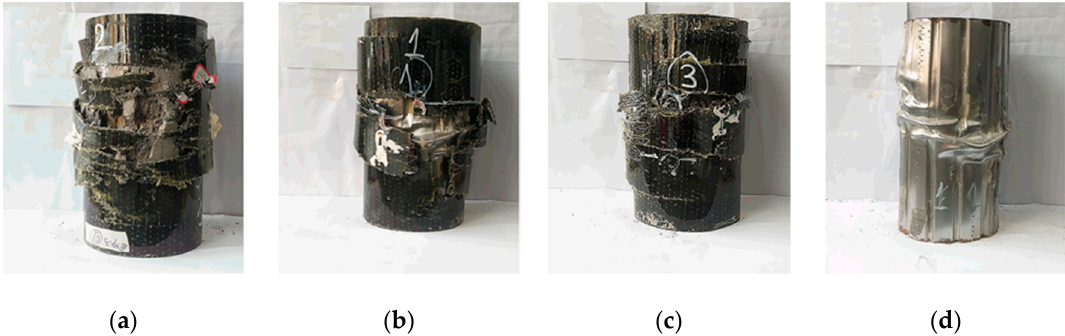
Figure 4. Failure mechanism: ( a ) Abrupt failure of hybrid DSTC; ( b ) initial stage of progressive failure for BFST-DSTC; ( c ) final stage of progressive failure for BFST-DSTC; ( d ) outward buckling and rupture of the outer steel layer in BFST-DSTC.